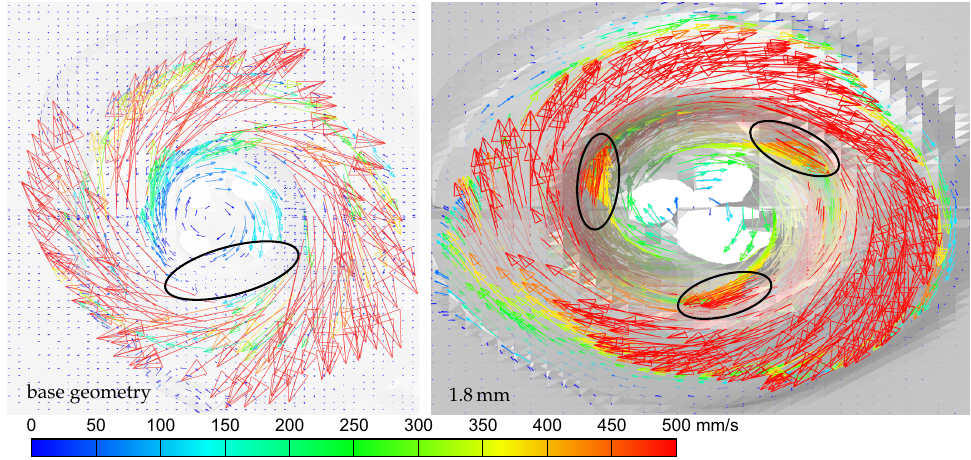
Figure 11. Velocity vectors for base geometry ( left ) and third design iteration with 1.8mm structure width ( right ). Tools not shown. Ellipse left: stagnation point. Ellipses right: induced material flow by and within structure.